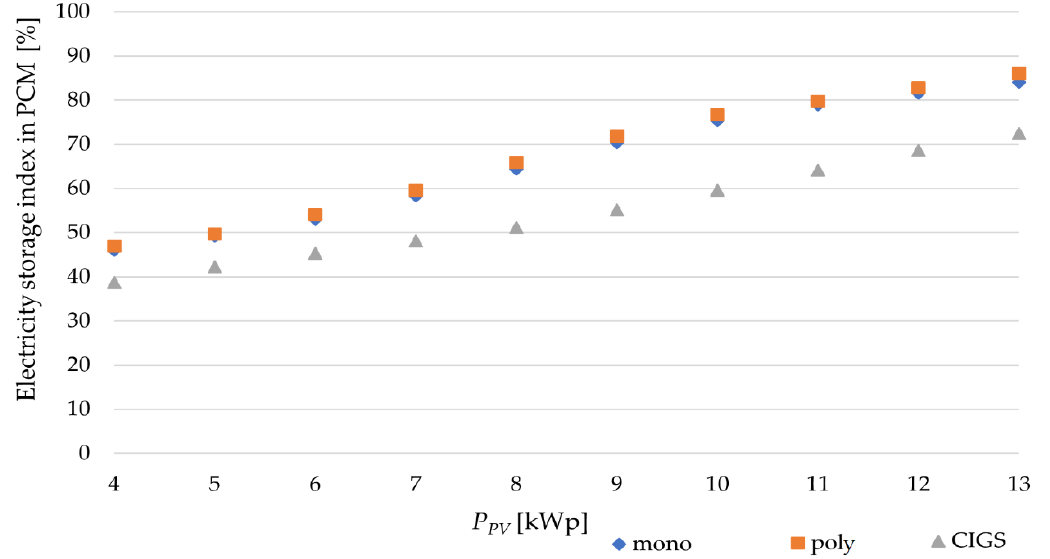
Figure 16. Electricity storage index in PCM as a function of PV power plant power—cloudy days. For the tested PV plants, on a clear day, we expect an energy yield of approx. 5.5 kWh · kWp − 1 for mono and polycrystalline panels and 4.3 kWh · kWp − 1 for CIGS. For cloudy days, these indicators are lower by 1.9 and 1.3 kWh · kWp − 1 , respectively. The available amount